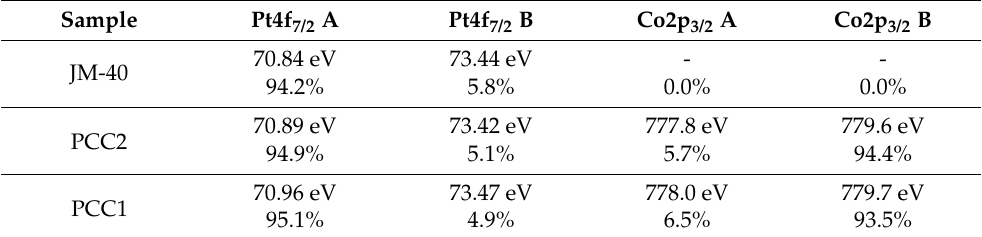
Table 2. Binding energies and the relative content of the Pt4f7/2 and Co2p3/2 components in the spectra of the studied samples.